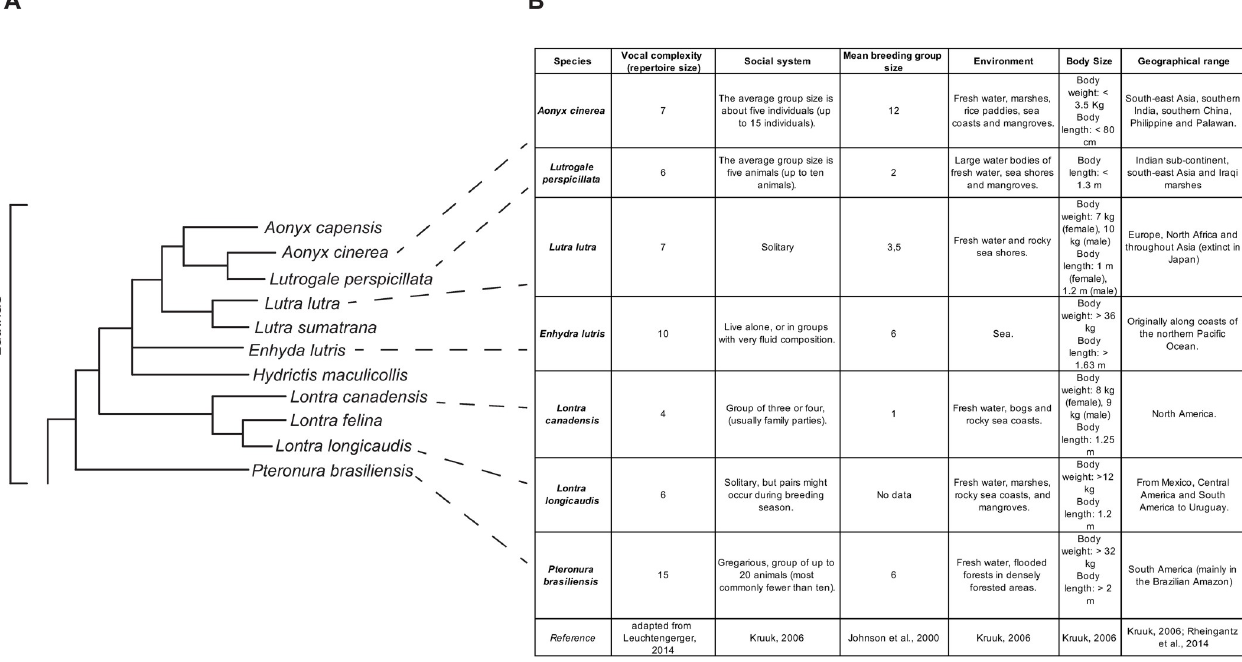
PLOS ONE | https://doi.org/10.1371/journal.pone.0251974 May 26,